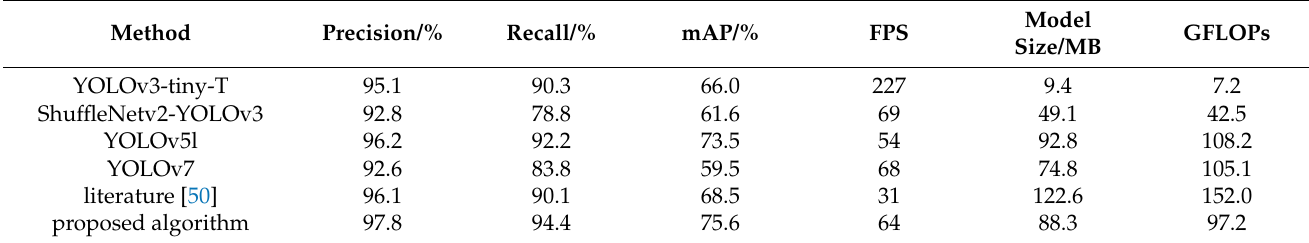
Table 1. Experimental results of different method on the EgoHands